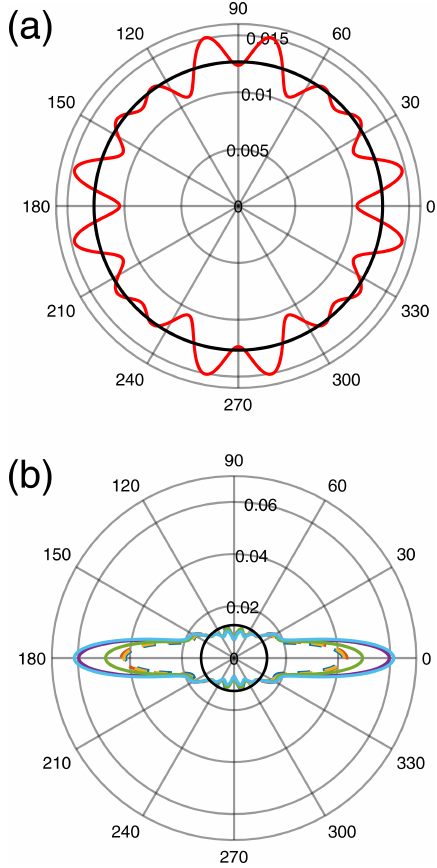
Figure 7. Orientation probability densities P ( β ) for six films de- posited under the same conditions with an applicator calculated from (a) a rotation of the sample about the Z axis ( β being the angle from the X axis in the X – Y plane) and (b) a rotation about the Y axis ( β being the angle from the Z axis in the X – Y plane). The black circles correspond to an isotropic